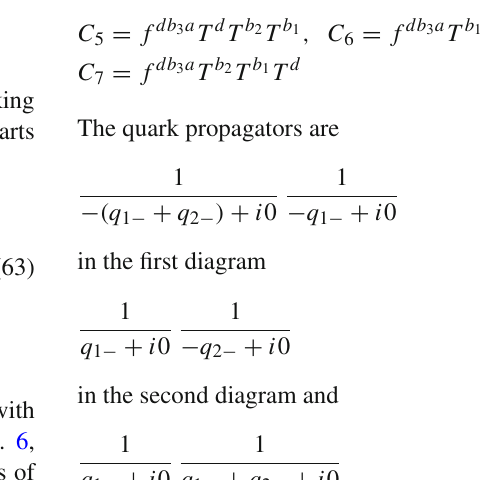
Fig. 6 Diagrams with the triple interaction of the